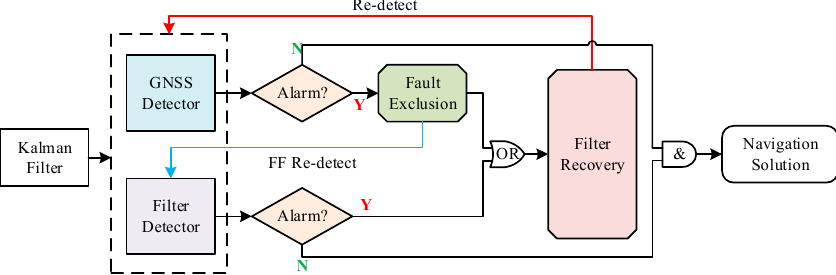
Figure 3. The architecture of the proposed Fault Detection and Exclusion (FDE) scheme.